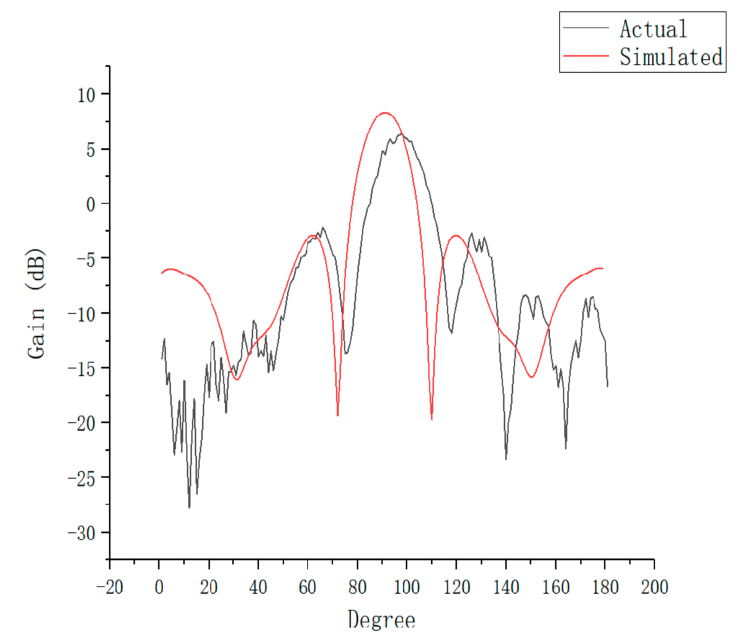
Figure 13. Comparison of test and